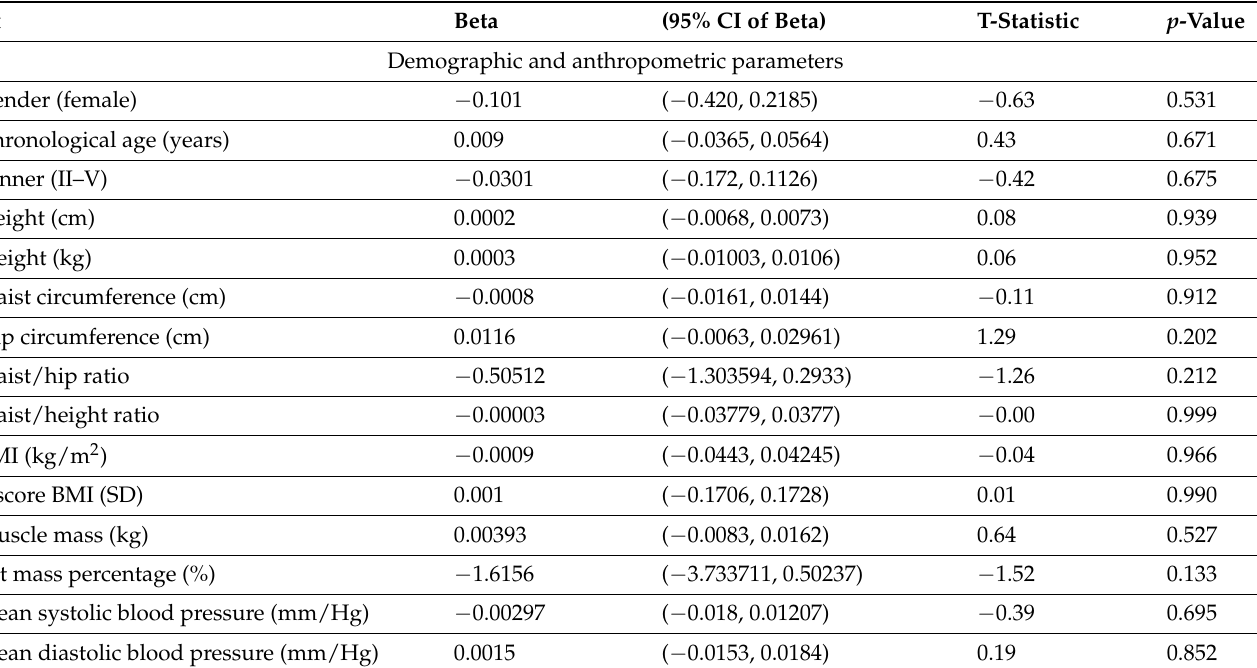
Table 1. Total steps 25–75% level of physical activity group (intermediate exercise level): correla- tions with basic demographic clinical and biochemical parameters with the use of univariant linear